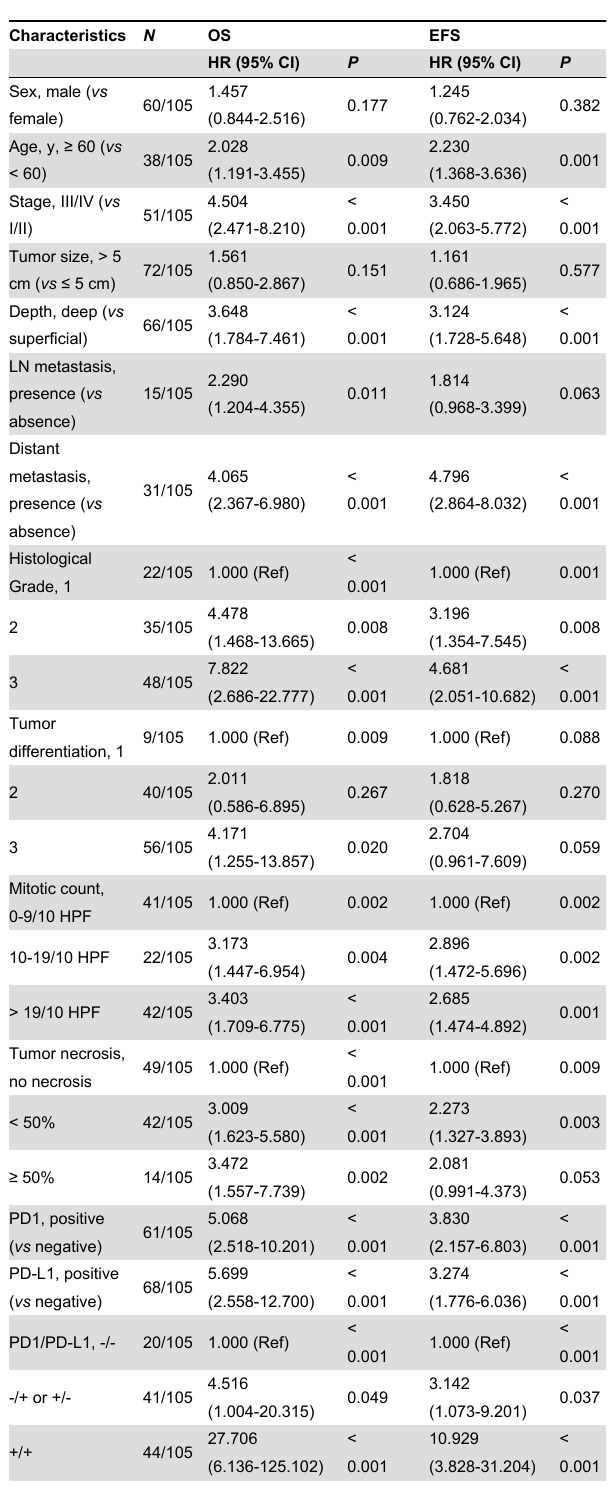
Table 3. Univariate Cox regression analysis for overall survival and event-free survival of soft-tissue sarcoma